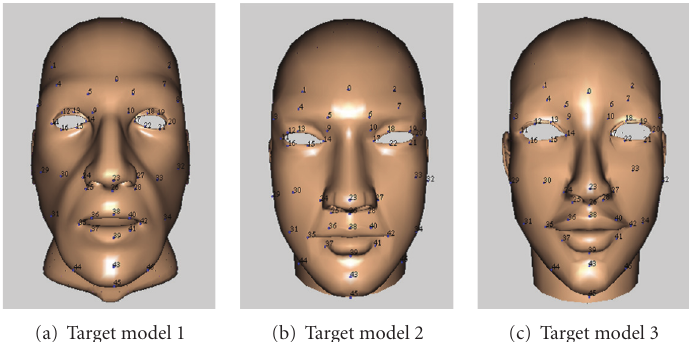
Figure 5: Expression cloning. In order to copy expressions from the source model, exactly identical facial control points of the source model have to be defined on the target model. The selection of facial control points is done manually.